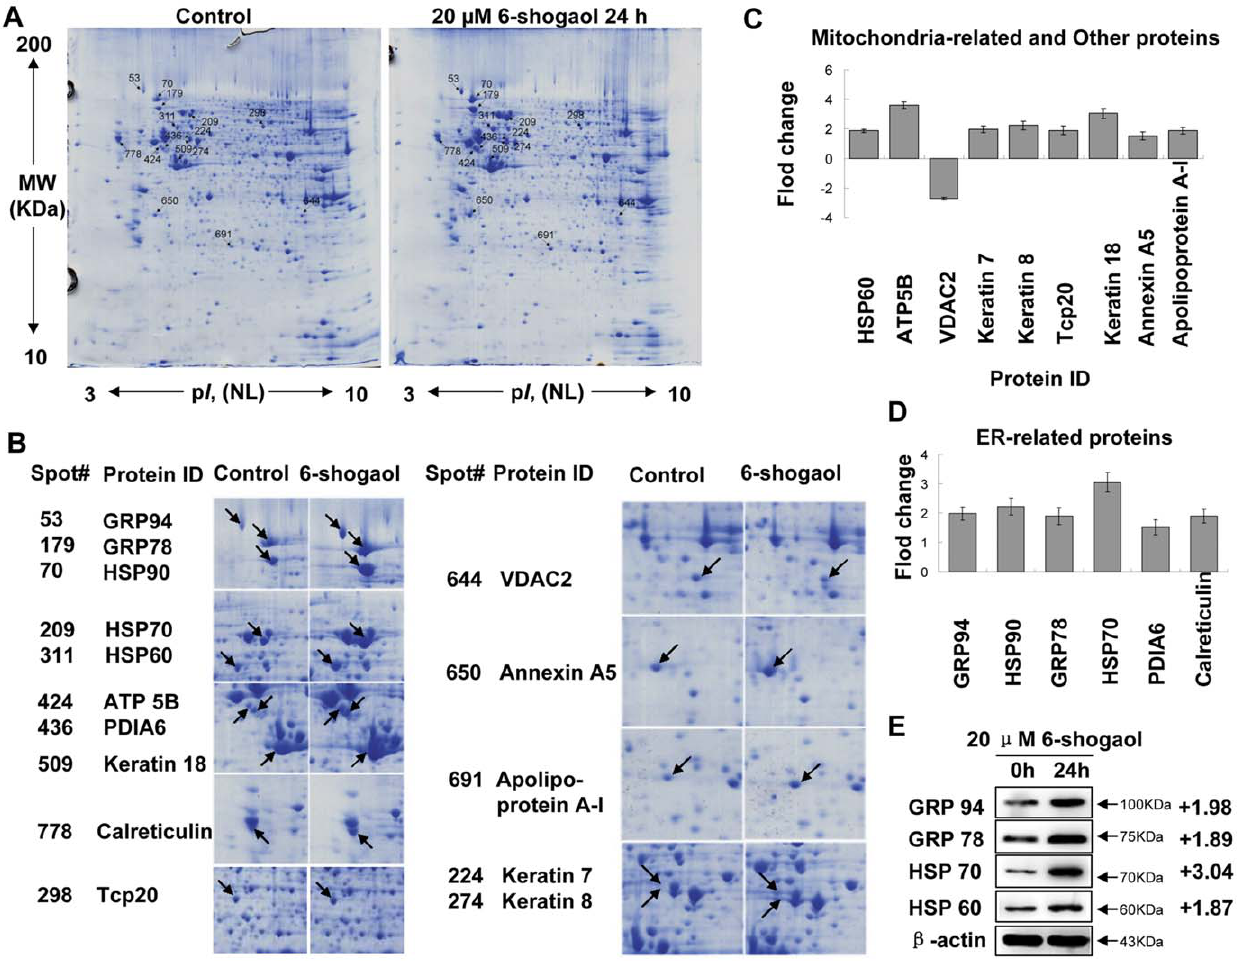
Figure 2. 2-DE images of total cellular proteins extracted from 6-shogaol-treated SMMC-7721 cells. (A) SMMC-7721 cells were treated with or without 20 m M 6-shogaol for 24 h. Differentially expressed spots are shown by the arrows. (B) The expanded region of altered protein spots, the proteins with arrow are the differentially expressed proteins identified by MS. (C) The intensity of mitochondria-related and other proteins. (D) The intensity of ER-related proteins. (E) Western bolt imaging of GRP94, GRP78, HSP70 and HSP60. For Western blot analysis, each lane was loaded with 30 m g of protein. Blots were subsequently stripped and reprobed with antibody against b -actin to ensure equivalent loading and transfer. Two additional studies yielded equivalent results.